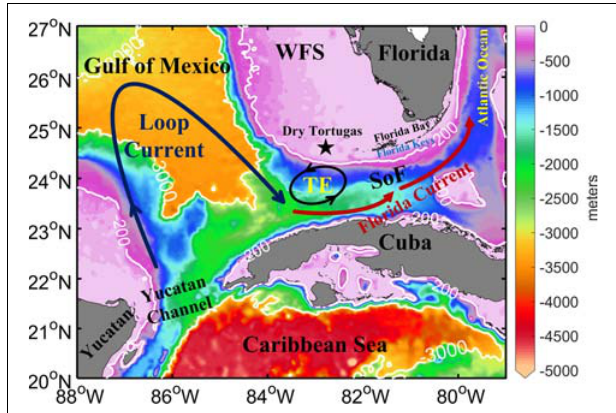
FIGURE 1 | Bathymetry of the southeastern GoM, SoF, and northwestern Caribbean Sea. The 200 and 3,000 m isobaths are annotated with white lines, and the LC and FC are annotated with dark blue and red curves with arrows, respectively. Important bathymetric or geographic features are also noted: the GoM, WFS, SoF, Florida Keys, Florida Bay, Atlantic Ocean, Caribbean Sea, and the Yucatan Channel (YC). The location of the DT is marked with a black pentagram. The black closed circle near the DT indicates the regular location of TEs when they keep quasi-stationary off the